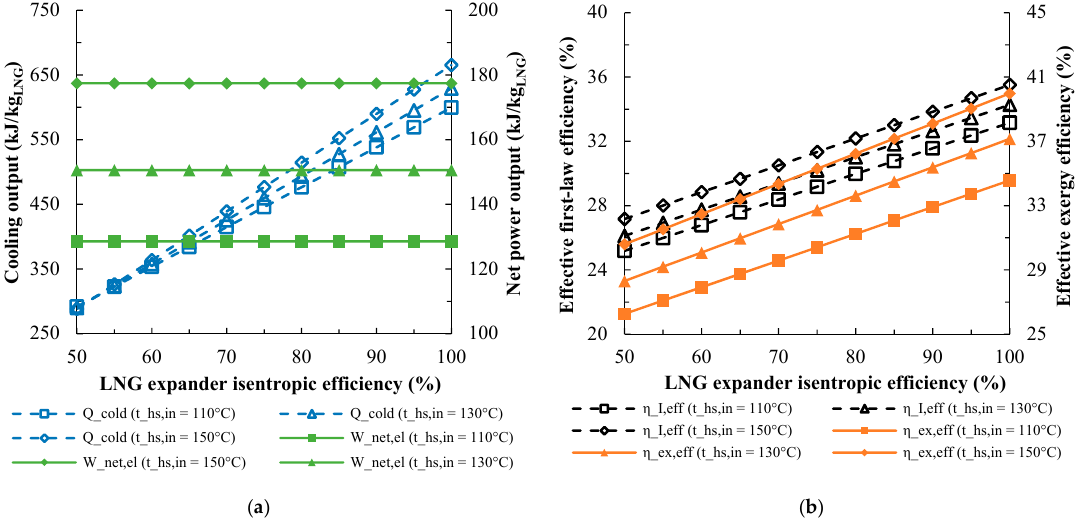
Figure 8. Effect of LNG expander isentropic efficiency on poly-generation system performance at di ff erent heat source temperatures ( t 18 = 110 ◦ C, 130 ◦ C, and 150 ◦ C): ( a ) Useful cooling and electrical power outputs; ( b ) Overall efficiencies.